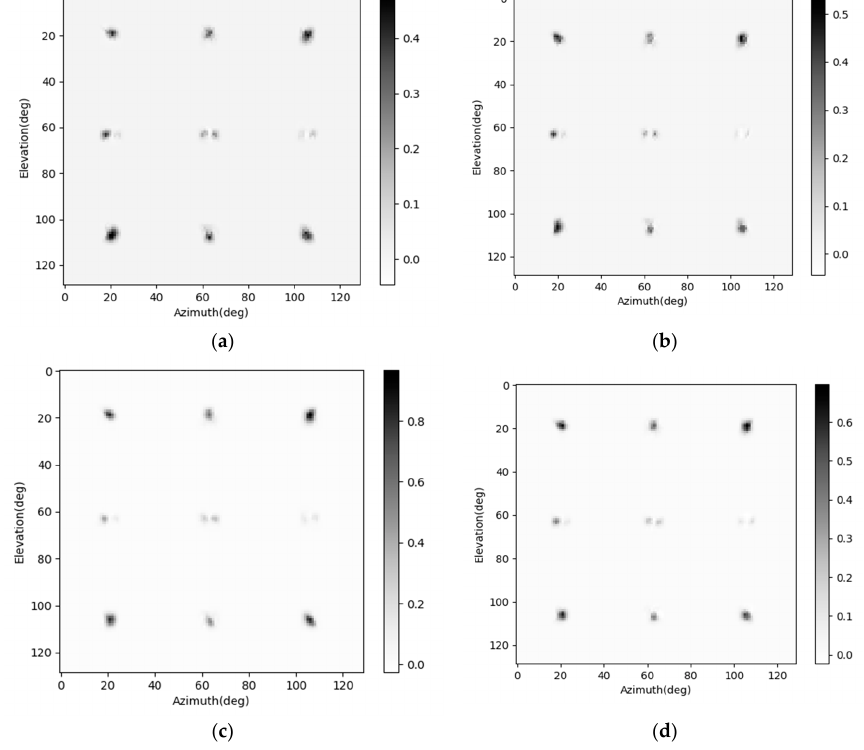
Figure 10. Guided backpropagation on position-coding of the 6th layer. ( a ) Results on the 1st position-coding channel; ( b ) results on the 2nd position-coding channel; ( c ) results on the 3rd position-coding channel; ( d ) results on the 4th position-coding channel.